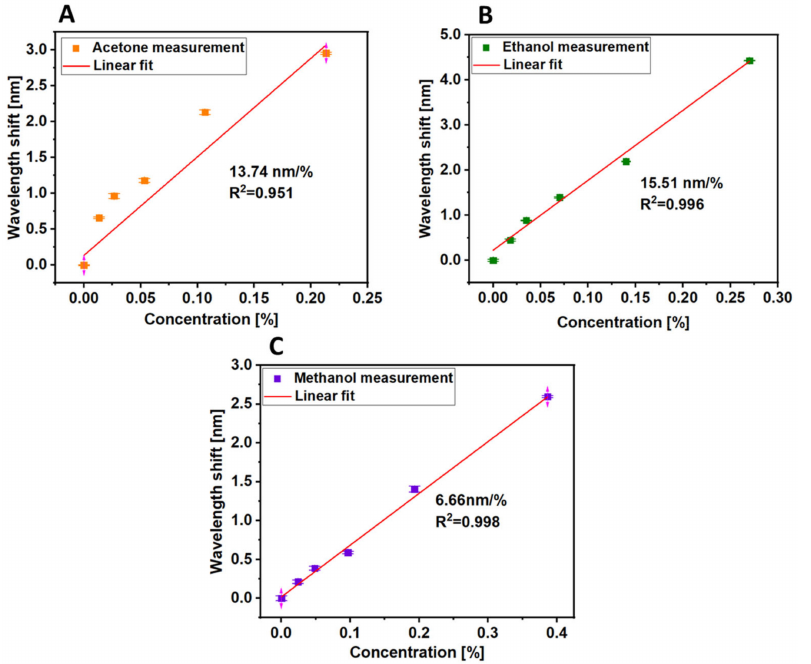
Figure 9. Sensitivity investigation of 120-cycle-coated MOF sensor for different VOCs: ( A ). acetone in range of 0.0–0.21% (yellow points), ( B) . ethanol in range of 0.0–0.27% (green points) and ( C ). methanol in range of 0.0–0.39% (purple points).